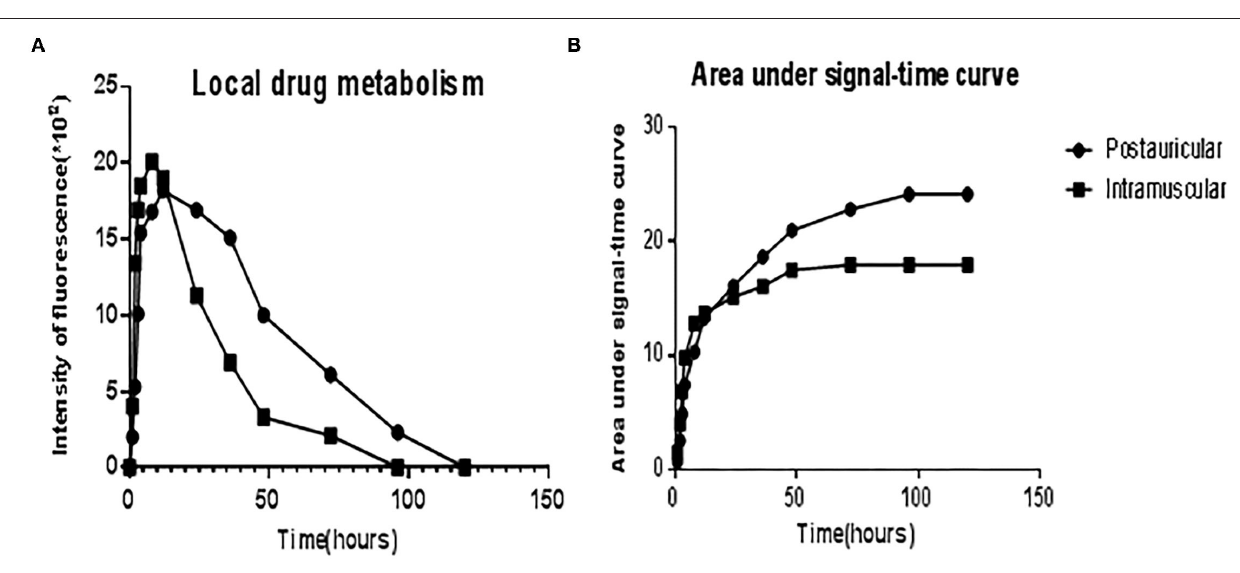
Frontiers in Neurology |